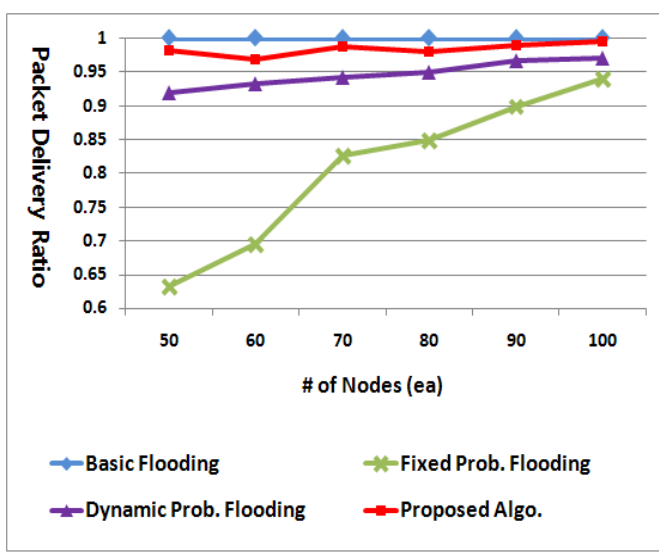
Figure 11. Packet delivery